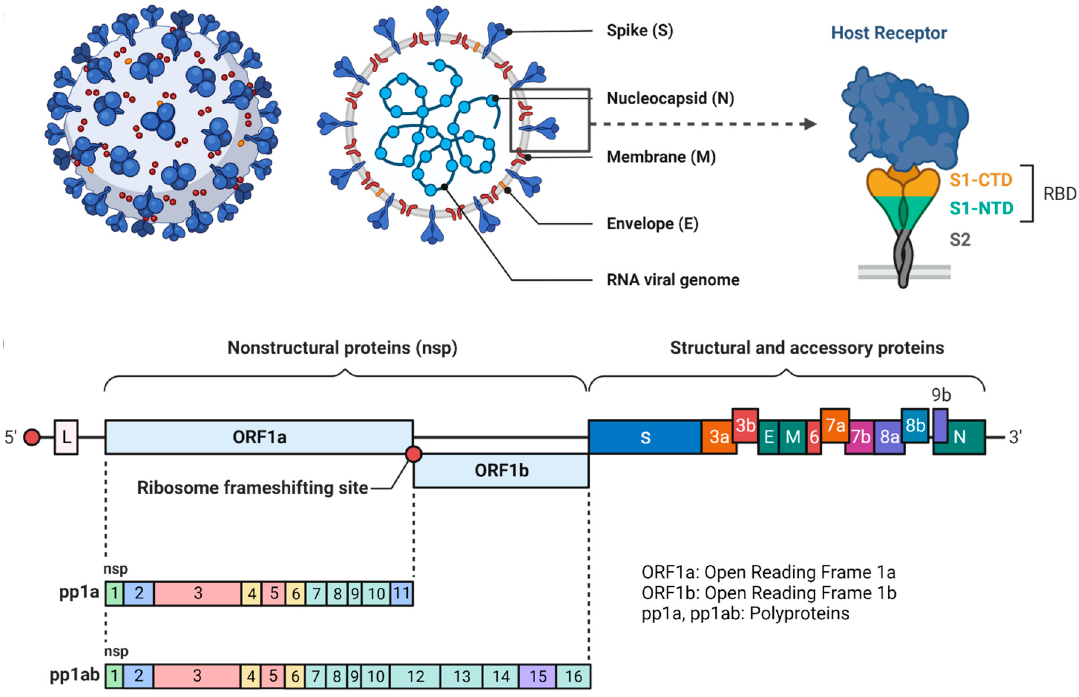
Figure 2. Genomic structure of coronavirus. (Created with BioRender.com accessed on 31 December